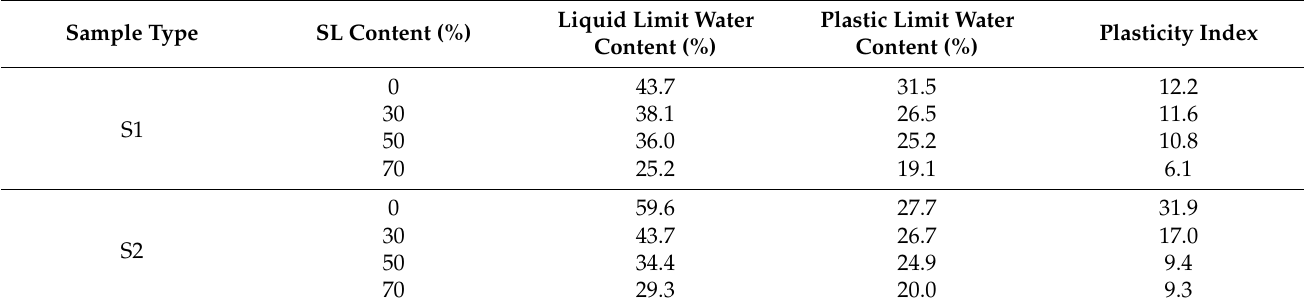
Table 2. Limit water content of soil mixed with different SL contents.